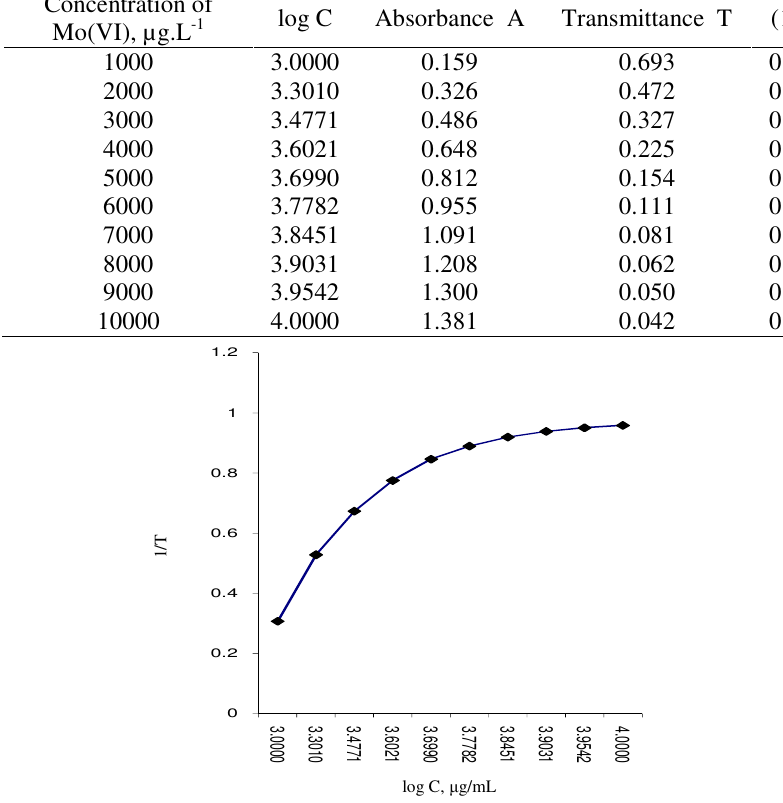
Figure 4. Ringbom plot of Mo(VI)-GPPH